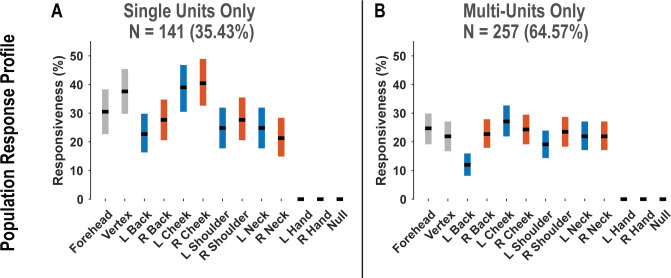
Postcentral-intraparietal (PC-IP) population responsiveness is not qualitatively changed by pooling together single and multi-units.(A) Percentage of the PC-IP neuronal population that demonstrated significant modulation (tuning) to each tested stimulation site (p<0.05, false discovery rate corrected) when considering only high-quality single units. Within each bar, the black horizontal line represents the mean and the width of the bar represents the bootstrapped 95% confidence interval. Gray bars represent truncal (midline) body locations, blue bars represent left-sided sites, and orange bars represent right-sided sites. (B) Similar to A, but considering potential multi-units. N: sample size; L: left; R: right.